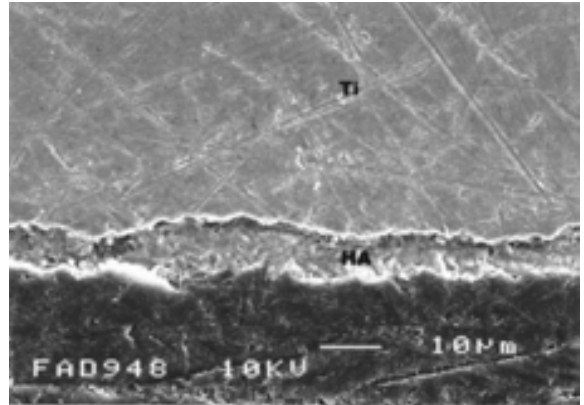
Figure 2. Hydroxyapatite coated implant under high magnification. (x 10.000).